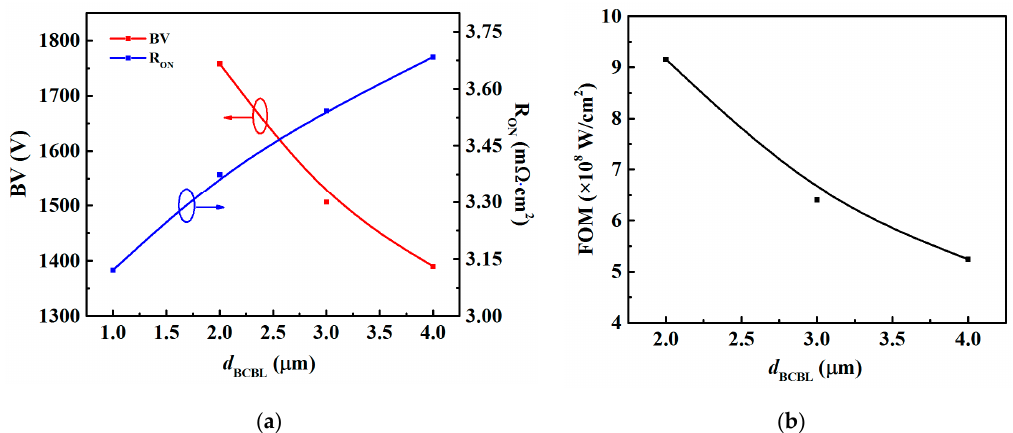
Figure 3. ( a ) Breakdown voltage (BV) and on-resistance (R ON ) versus d BCBL (the distance between the source and the BCBL) and ( b ) figure of merit (FOM) values versus d BCBL